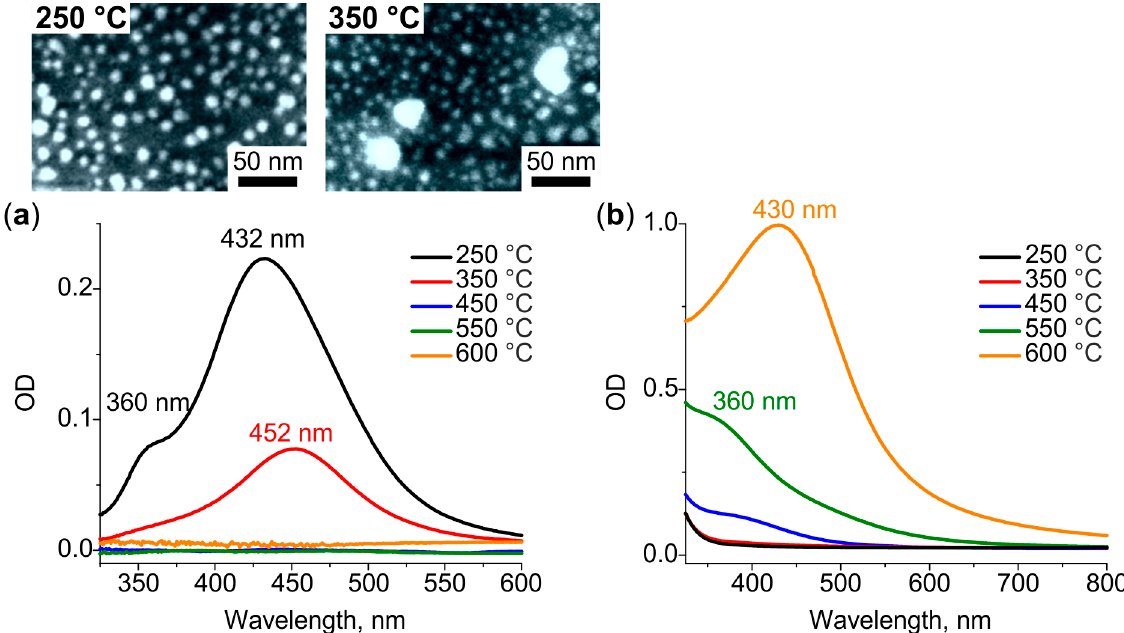
Figure 2. ( a ) Differential and ( b ) bulk spectra corresponded to surface and bulk Ag NPs, respectively, formed in a glass containing Ag + ions after heat treatment in air at 250–600 °C. Inset: SEM images of surface Ag NPs formed at 250 °C and 350 °C.